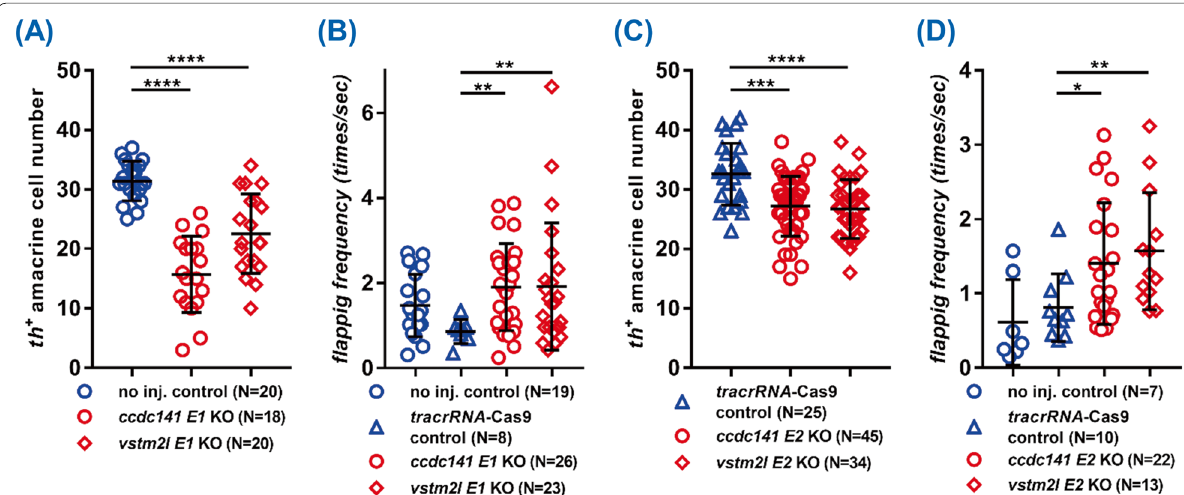
Fig. 4 The quantity of amacrine cells and flapping frequency of pectoral fins in the transient ccdc141 and vstm2l knocked‑out embryos. The statistical data showed that fewer th ‑expressing amacrine cells were observed in 4 dpf ( A ) ccdc141 and vstm2l exon 1 (E1) knocked‑out embryos . A statistically significant hyperkinetic movements were found in 5 dpf ( B ) ccdc141 and vstm2l exon 1 knocked‑out embryos. Fewer th ‑expressing amacrine cells were observed with statistical data in 4 dpf ( C ) ccdc141 and vstm2l exon 2 (E2) knocked‑out embryos. Hyperkinetic movements were found statistically significant in 5 dpf ( D ) ccdc141 and vstm2l exon 2 knocked‑out embryos, when compared to tracrRNA‑Cas9 control . The not‑injected AB wildtype embryos were used as no inj. control; for the exon 1‑targeting knockouts in ( A ) and ( B ), 200 pg tracrRNA and 200 pg Cas9 protein were injected per embryo as basic tracrRNA ‑Cas9; basic tracrRNA ‑Cas9 and 50 pg ccdc141 ‑ crRNA E1/ vstm2l ‑ crRNA E1 were injected per embryo for ccdc141 exon 1 /vstm2l exon 1 KO. For the exon 2‑targeting knockouts in ( C ) and ( D ), 138 pg tracrRNA and 461 pg Cas9 protein were injected per embryo as basic tracrRNA ‑Cas9; basic tracrRNA ‑Cas9 and 34.6 pg ccdc141 ‑ crRNA E2/ vstm2l ‑ crRNA E2 were injected per embryo for ccdc141 exon 2/ vstm2l exon 2 KO. Mann–Whitney U test was used for comparisons of unpaired nonparametric variables. All calculated P ‑values were two‑tailed, and statistical significance was defined as P ‑value less than 0.05. Symbol meaning: *, p p ≤